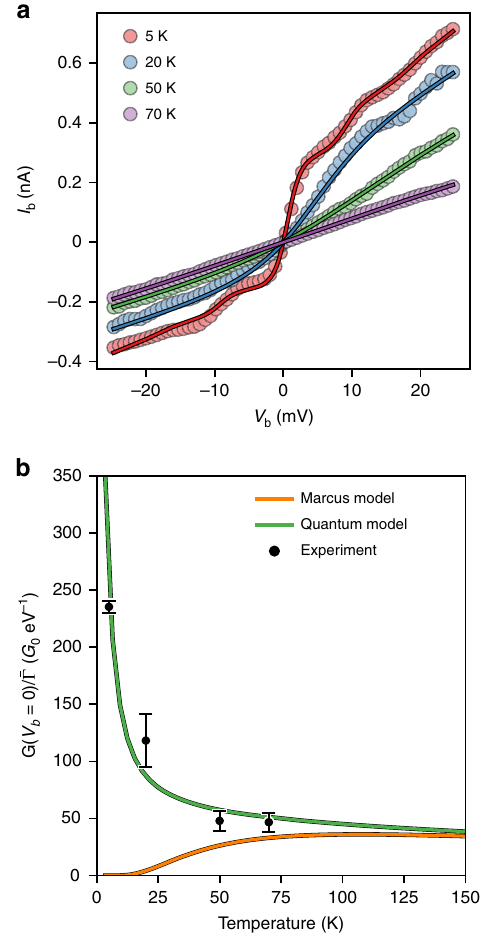
Γ = Γ þ Γ ð Þ ) as a function S D S D